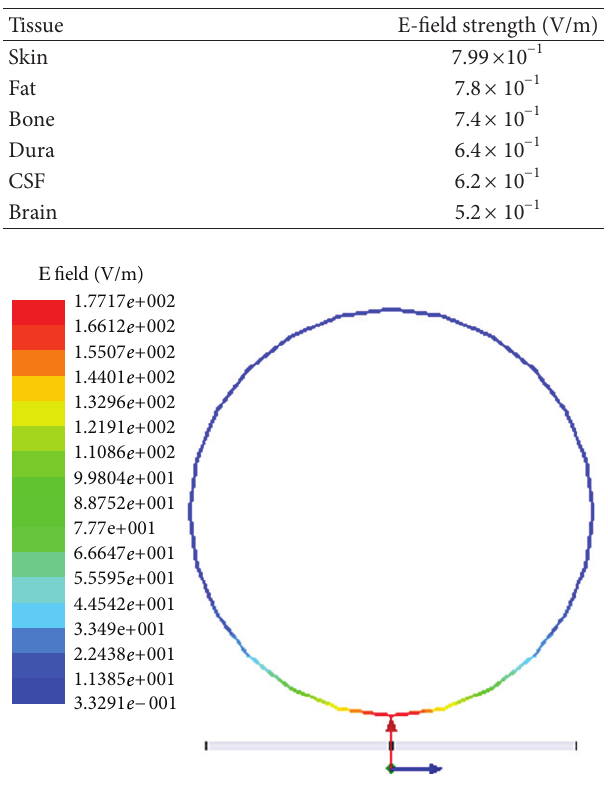
F 12: �-�eld strength in fat tissue at 900MHz.